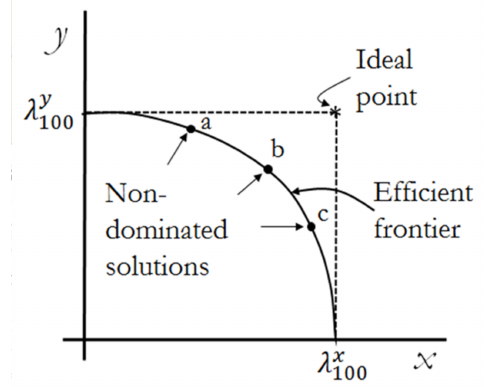
Figure 2. Representation of the ideal point, efficient frontier, non-dominated solutions, and trade-offs for two objectives. Point ‘b’ is the closest to the ideal point. The symbol λ represents the level of importance for each objective. From Yu (1973)